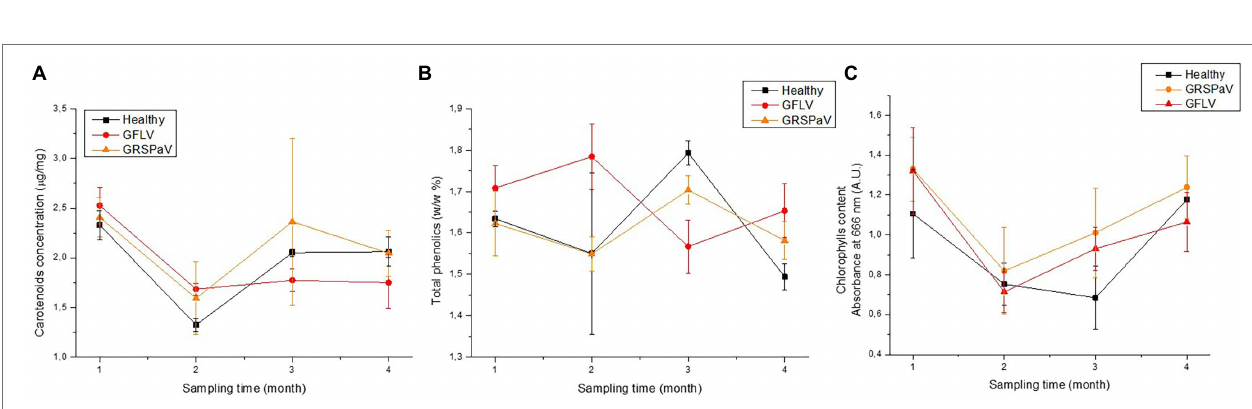
FIGURE 5 | PLS-DA model at T3 (A) and T4 (B) , with scores on latent variable 1 and 2 plots and Receiver Operating Characteristic (ROC) measurements for GFLV recognition from healthy plants.